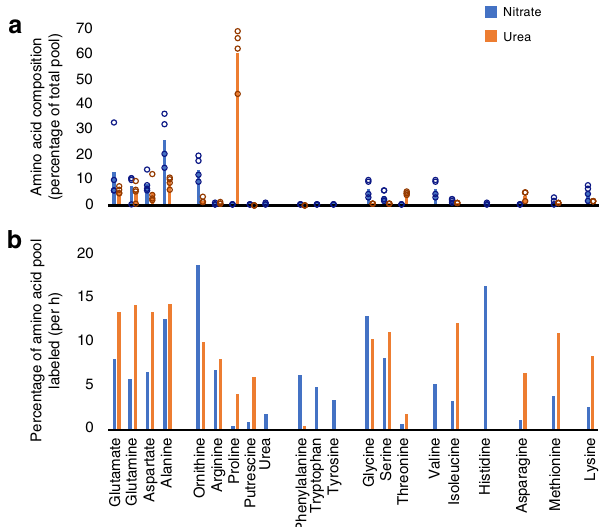
Fig. 7 Nitrogenous metabolite composition and labeling rate in P. tricornutum grown on nitrate and urea sources. a Cellular composition of nitrogenous metabolites expressed as a percentage of the total for the metabolites shown. Metabolites are grouped according to biosynthetic pathways. Data represent the average of four samples taken across the labeling period and are overlaid with individual data points. b 15 N-labeling rate, as the percentage of the metabolite pool that becomes labeled per hour calculated from the 3 h measurement. Source data are provided as a Source Data fi